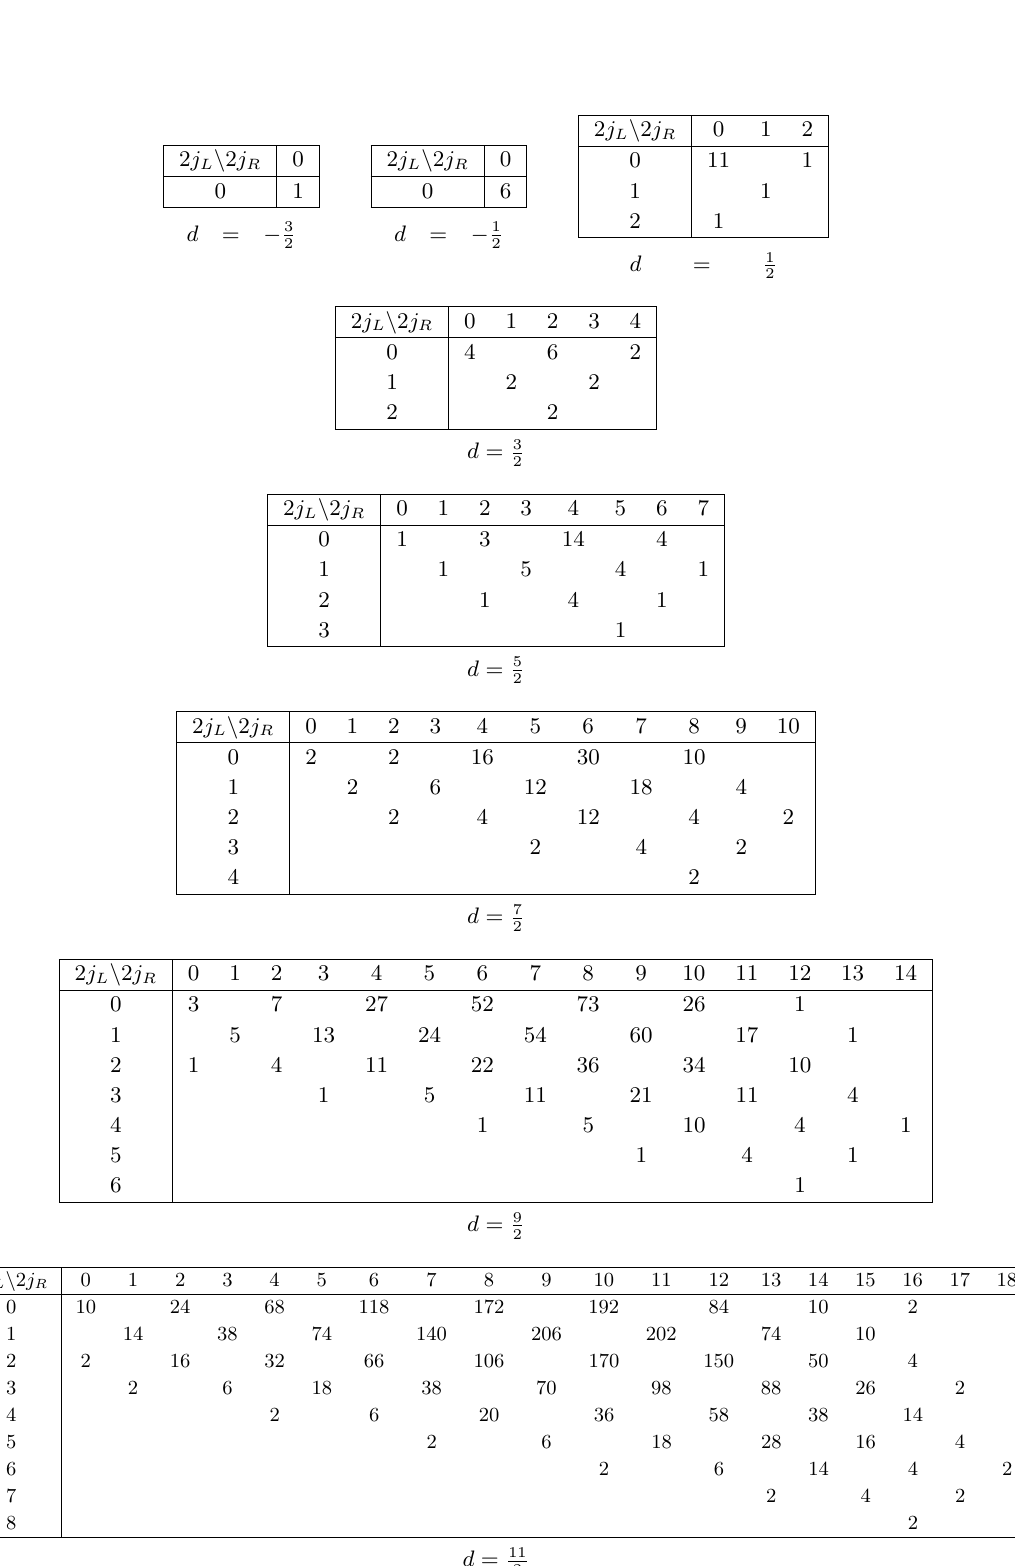
Table 12 . Pseudo-BPS spectrum of Wilson loop for local P 1 × P 1 in the representation 2 ⊗ 2 ⊗ 2 of SU(2) for the curve class dt = 2 dφ